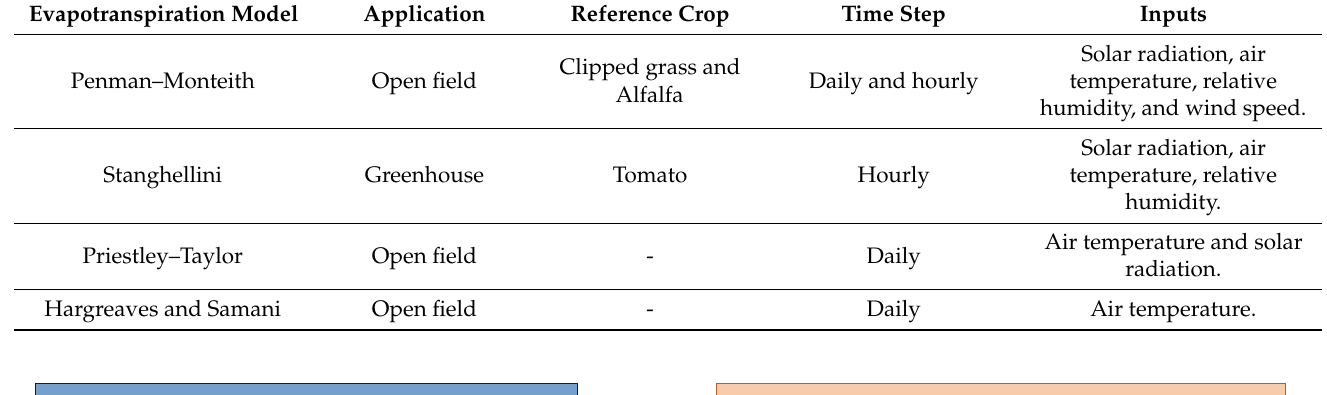
Table 2. Summary of evapotranspiration models (adapted from [46]).